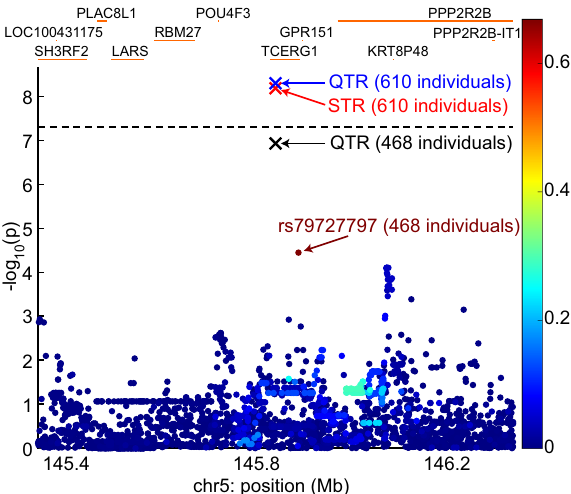
Fig. 4 Locus zoom plot showing the relationship of rs79727797 association with residual age at onset to that of the sum of two quasi-tandem repeat (QTR) lengths (black cross) in 468 subjects with both single nucleotide variant (SNV) and sequencing data. The associations of age at onset with the sum of STR (red cross) and QTR (blue cross) repeat lengths in all 610 subjects are also shown. The bar on the right of the plot indicates the strength of linkage disequilibrium (r2) between each SNV and the tandem repeat. The p -value threshold for genome-wide signi fi cance (5 × 10 − 8 ) is shown with a black dashed